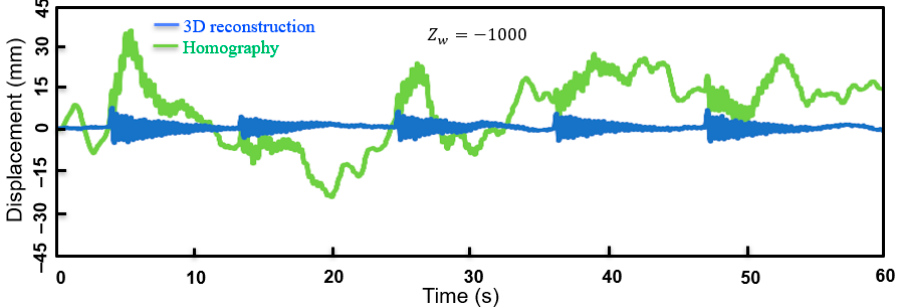
Figure 19. Comparison of displacement corrected by 3D reconstruction and homography methods ( Z w = − 1000).